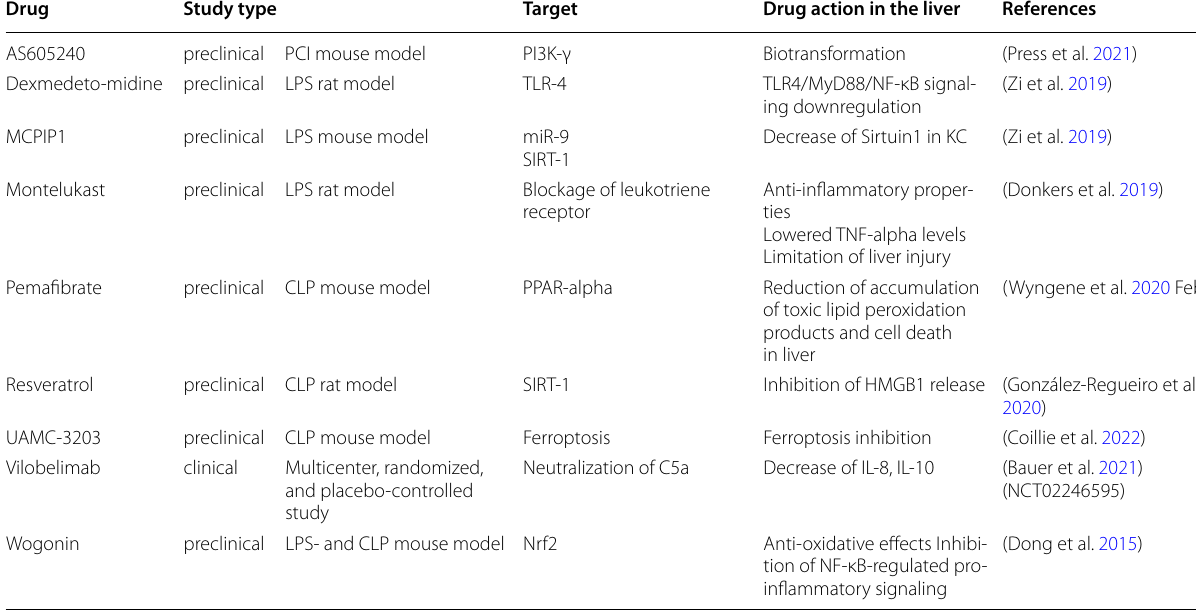
Table 2 Therapeutic strategies, their targets, and main actions to prevent liver failure